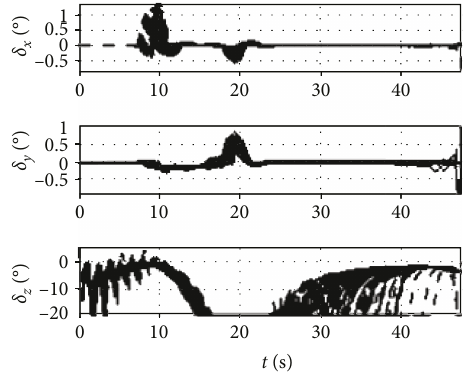
Figure 26: Curves representing the fi n de fl